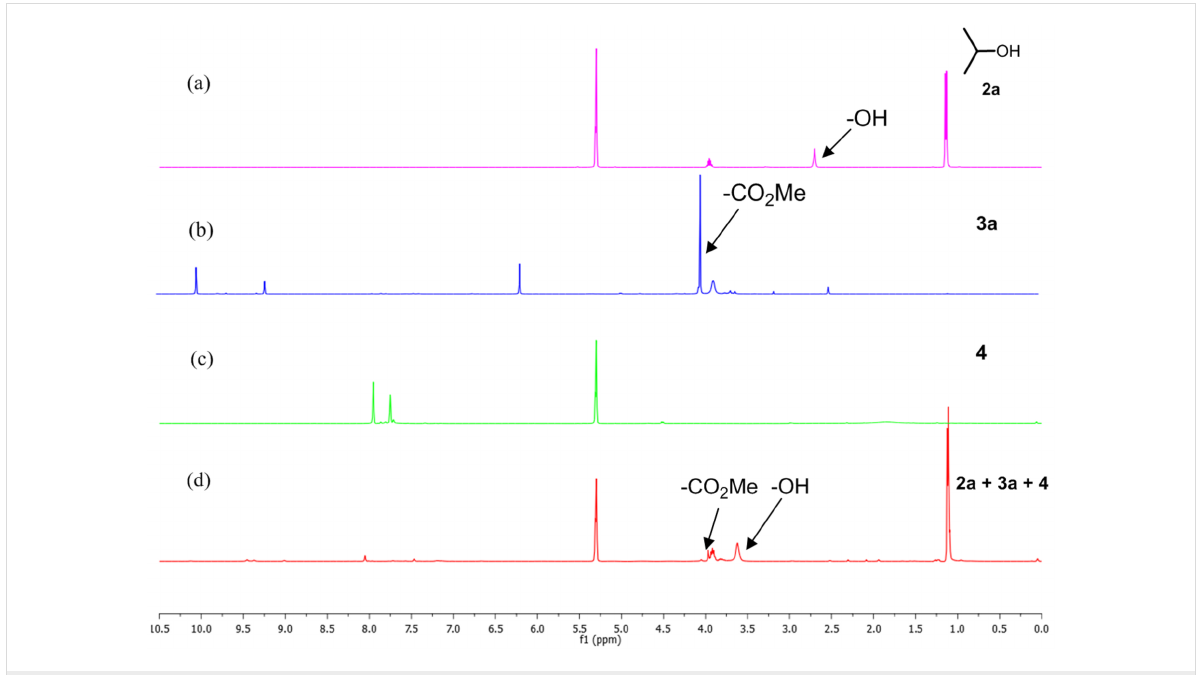
Figure 3: 1 H NMR (a) glycosyl acceptor 2a , (b) pyridinium salt 3a (in DMSO-d 6 ), (c) aryl thiourea and (d) a mixture of 2a , 3a (10 mol %) and 4 (10 mol %) in CD 2 Cl 2 at room temperature.